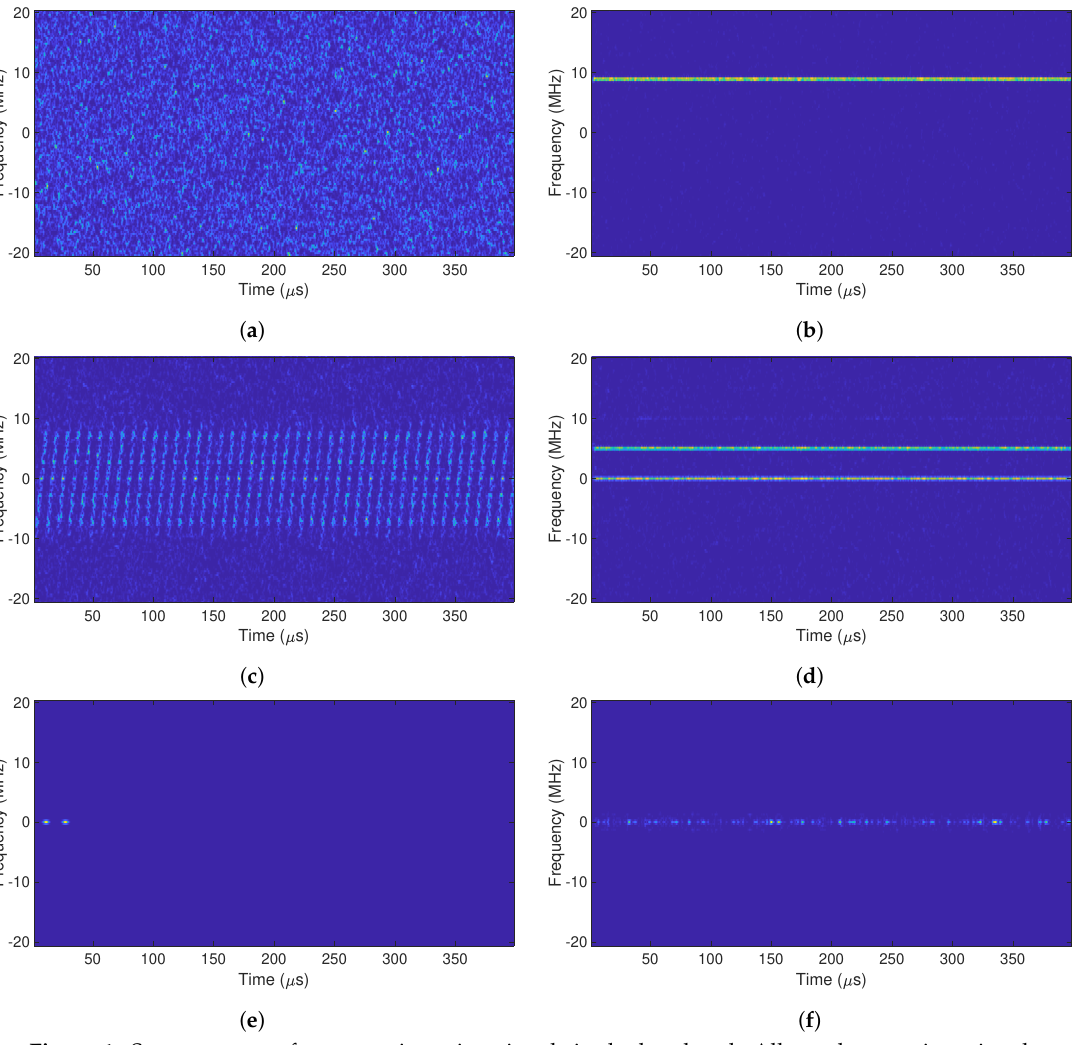
Figure 1. Spectrograms of common jamming signals in the baseband. All graphs contain a signal mixture of the jamming signal and the GPS L1 signal, where the C / N 0 is 45dB and the JSR is 50dB. ( a ) No jammer. ( b ) AM jammer. ( c ) Chirp jammer. ( d ) FM jammer. ( e ) Pulse jammer. ( f ) NB